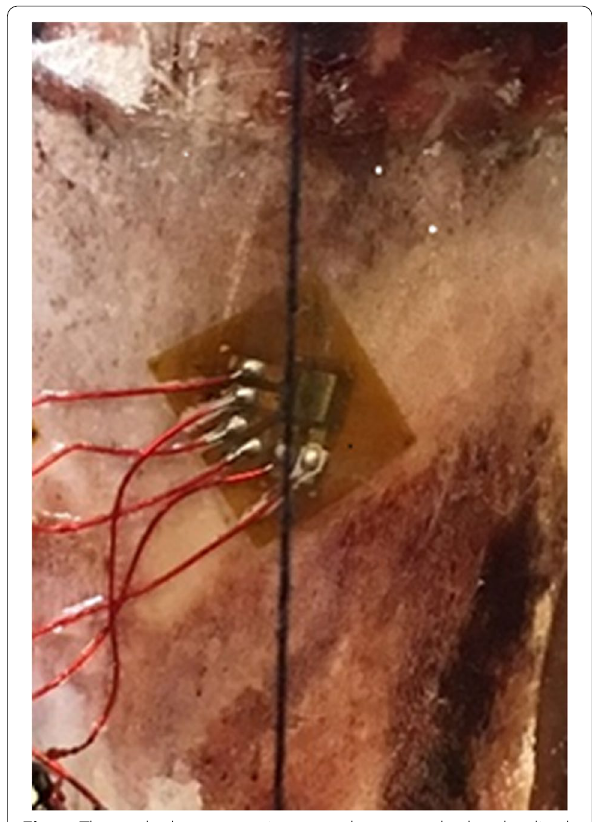
Fig. 1 The stacked rosette strain gauge shown attached to the distal fibula